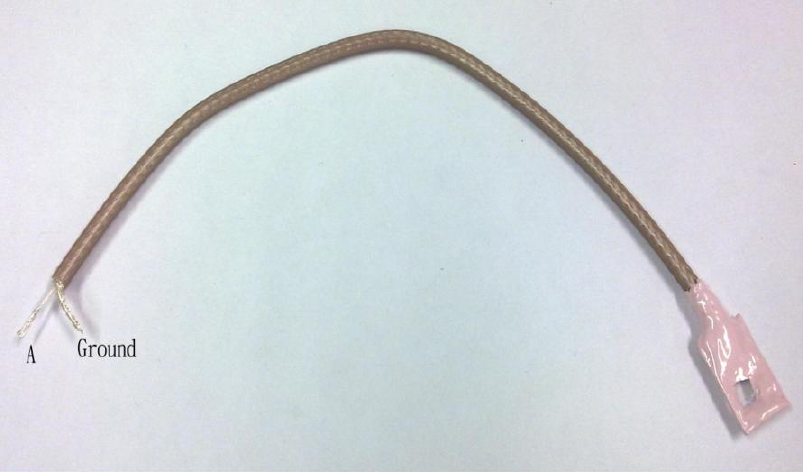
Figure 2. Practical pH electrode connected with a coaxial